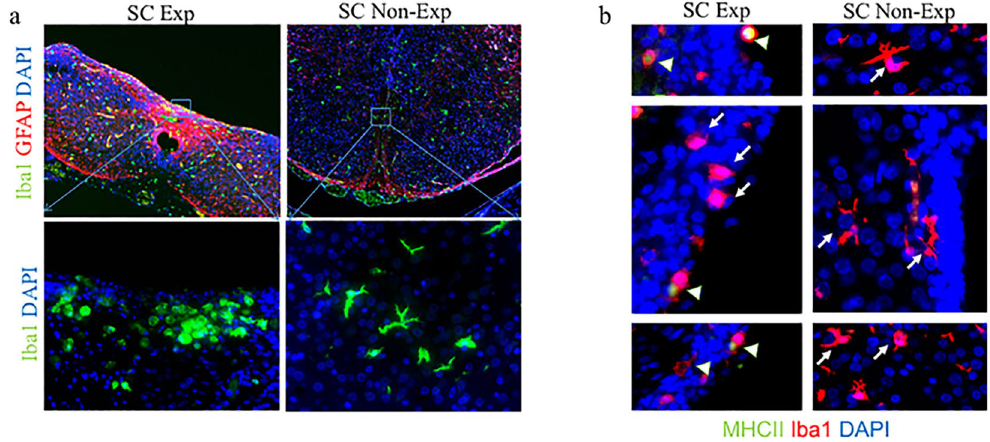
Figure 6. Progressive microglia activation in spinal cord exposed tissue in spina bifida. ( a ) Immunoreactive astrocytes GFAP (red), microglia Iba1 (green), and DAPI (blue) in exposed and un-exposed spina bifida spinal cords; top panel (magnification 20 × ). Activated rounded microglial morphology in exposed spinal cord in the layers exposed to the amniotic fluid compared with resting morphology in the unexposed spinal cord in spina bifida pups; lower panel (magnification 40 × ). ( b ) Iba1 (red), MHCII (green) and DAPI (blue) immunostaining in exposed and unexposed spina bifida cords. Iba1 + /MHCII − (arrows) and Iba1 + /MHCII + (arrowheads) microglial cells in layers of the spinal cord exposed to the amniotic fluid (magnification 100 × ) also showed activated phenotype compared with Iba1 + /MHCII − (arrows) microglial cells in resting phenotype with extended projections in unexposed spinal cords (magnification 100 ×